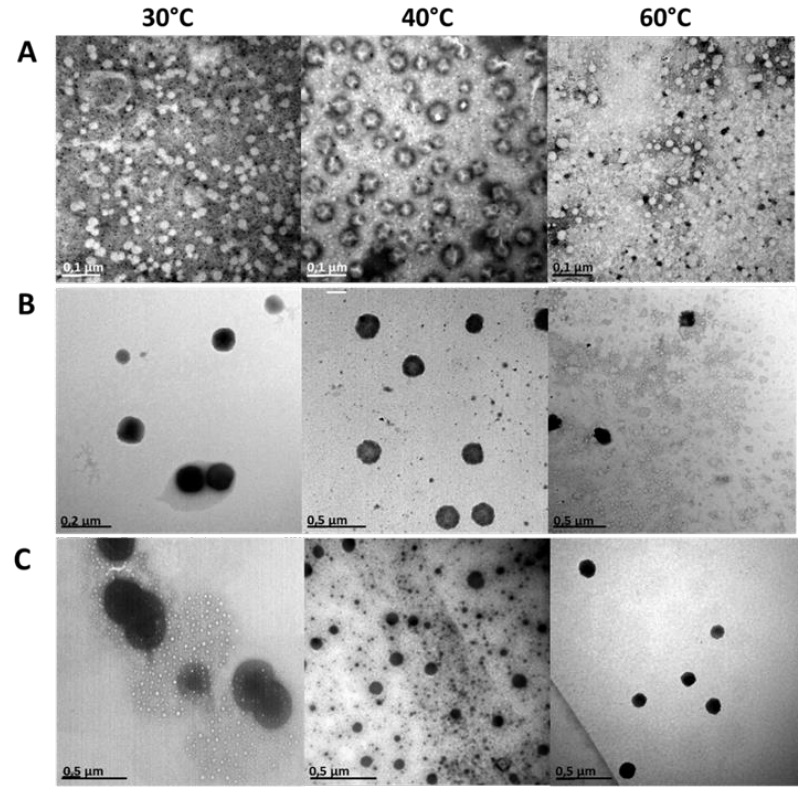
Figure 6. Pictures obtained from HR-TEM of niosomes at different temperatures of 30 °C, 40 °C, and 60 °C. ( A ) Niosomes with rifamycin encapsulated in MilliQ water as the aqueous phase; ( B ) Niosomes with rifamycin S encapsulated in a mixture of MilliQ water and glycerol (60:40 v / v ); ( C ) Niosomes with rifamycin S encapsulated in a mixture of MilliQ water and PEG 400 (44.7:55.3 v / v ). Table 3. Physical properties of vesicles hydrated in three aqueous phases at room temperature and heated at different temperatures (30 ◦ C, 40 ◦ C and 60 ◦ C), fresh and after 3 days of